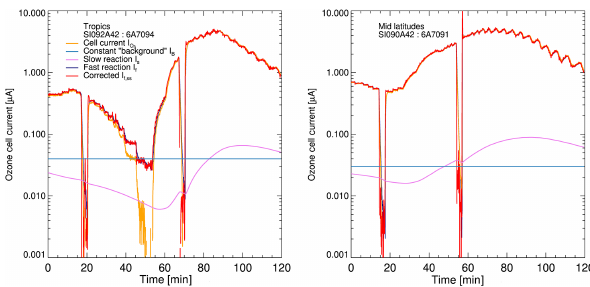
Figure 5. Same data as Fig. 3 showing the time response periods after about 1h. (a) Tropical simulation, (b) midlatitude simulation. The differences are shown as absolute differences since the refer- ence achieves zero